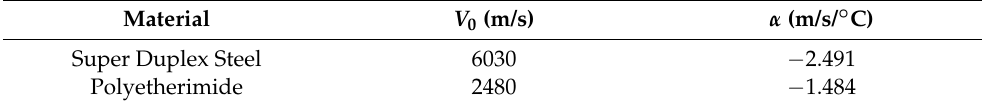
Table 2. Parameters V 0 and α defined, to super duplex steel and polyetherimide, by linear regression. Material V 0 (m/s) α (m/s/ ◦ C) Super Duplex